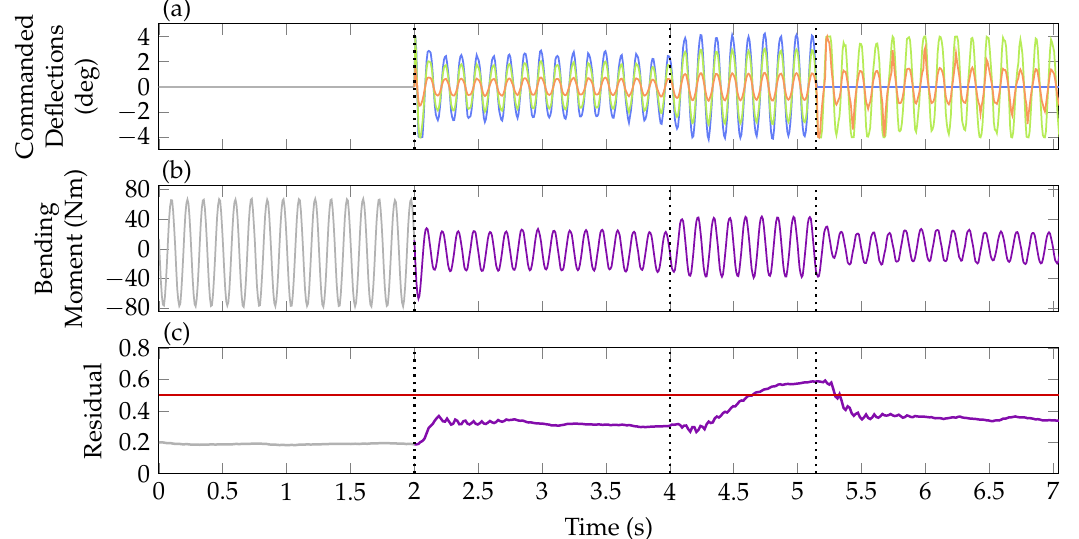
Figure 14. Input and output data of the fault tolerant control experiment for sinusoidal pitch excitations. The diagrams show the commands for the inner ( ), mid ( ) and outer ( ) control surface in ( a ), measured bending moment in ( b ) and the residual with its threshold ( ) in ( c ). In ( b , c ), open-loop operation is indicated by ( ) and closed-loop operation by (